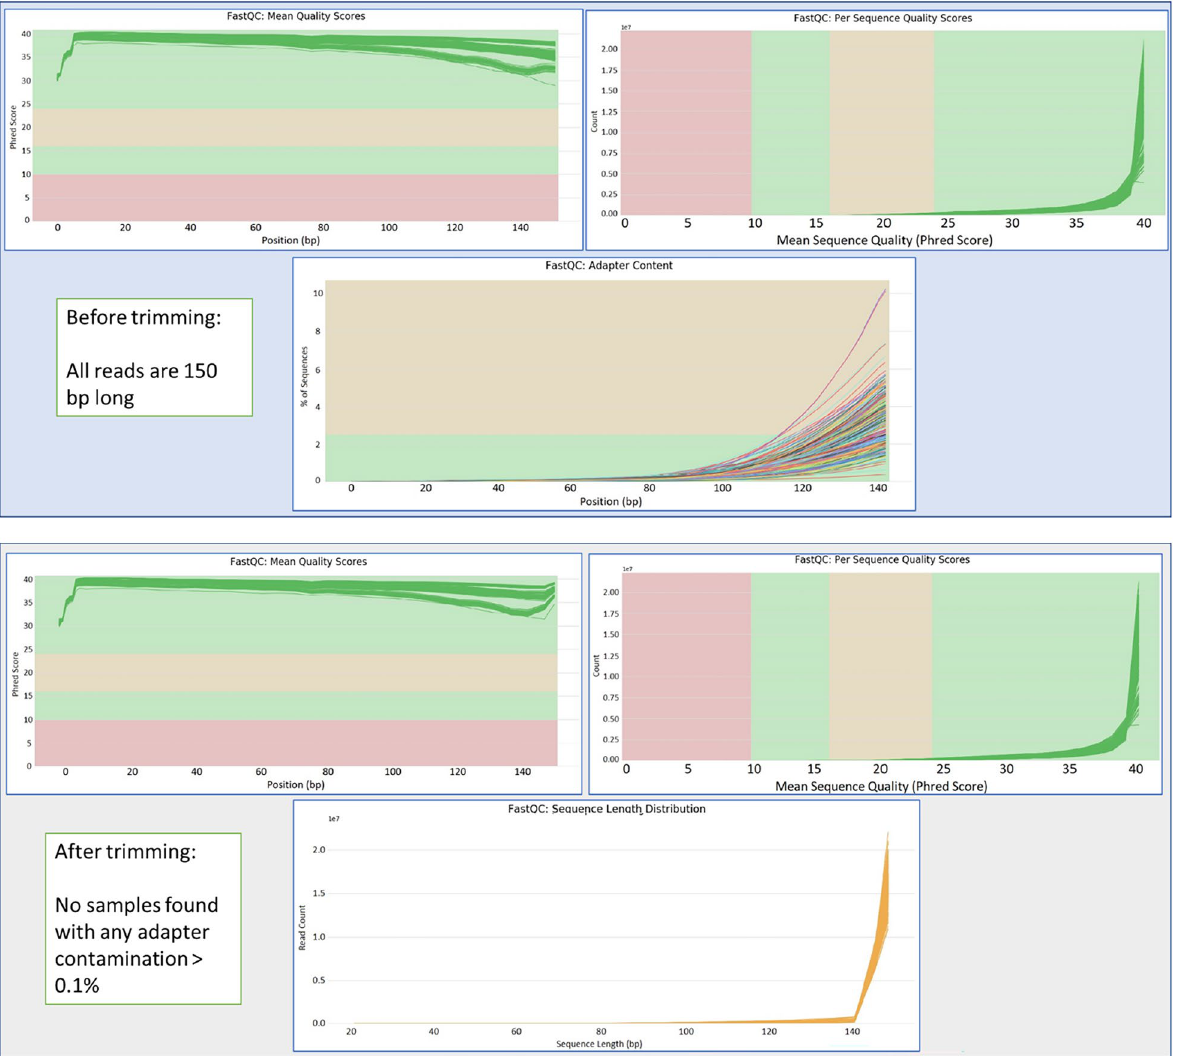
Figure 2. Quality assessment metrics before and after trimming the RNA-Seq samples. All raw reads were 150 bp long and after trimming, some adaptor sequence fragments were removed from the tail